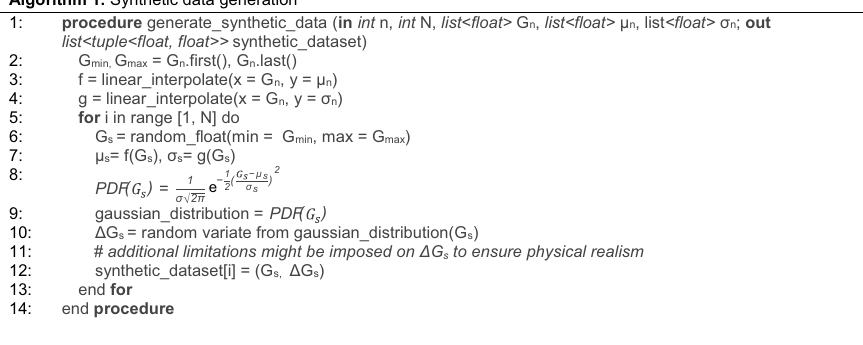
Algorithm 1. Synthetic data generation 1: